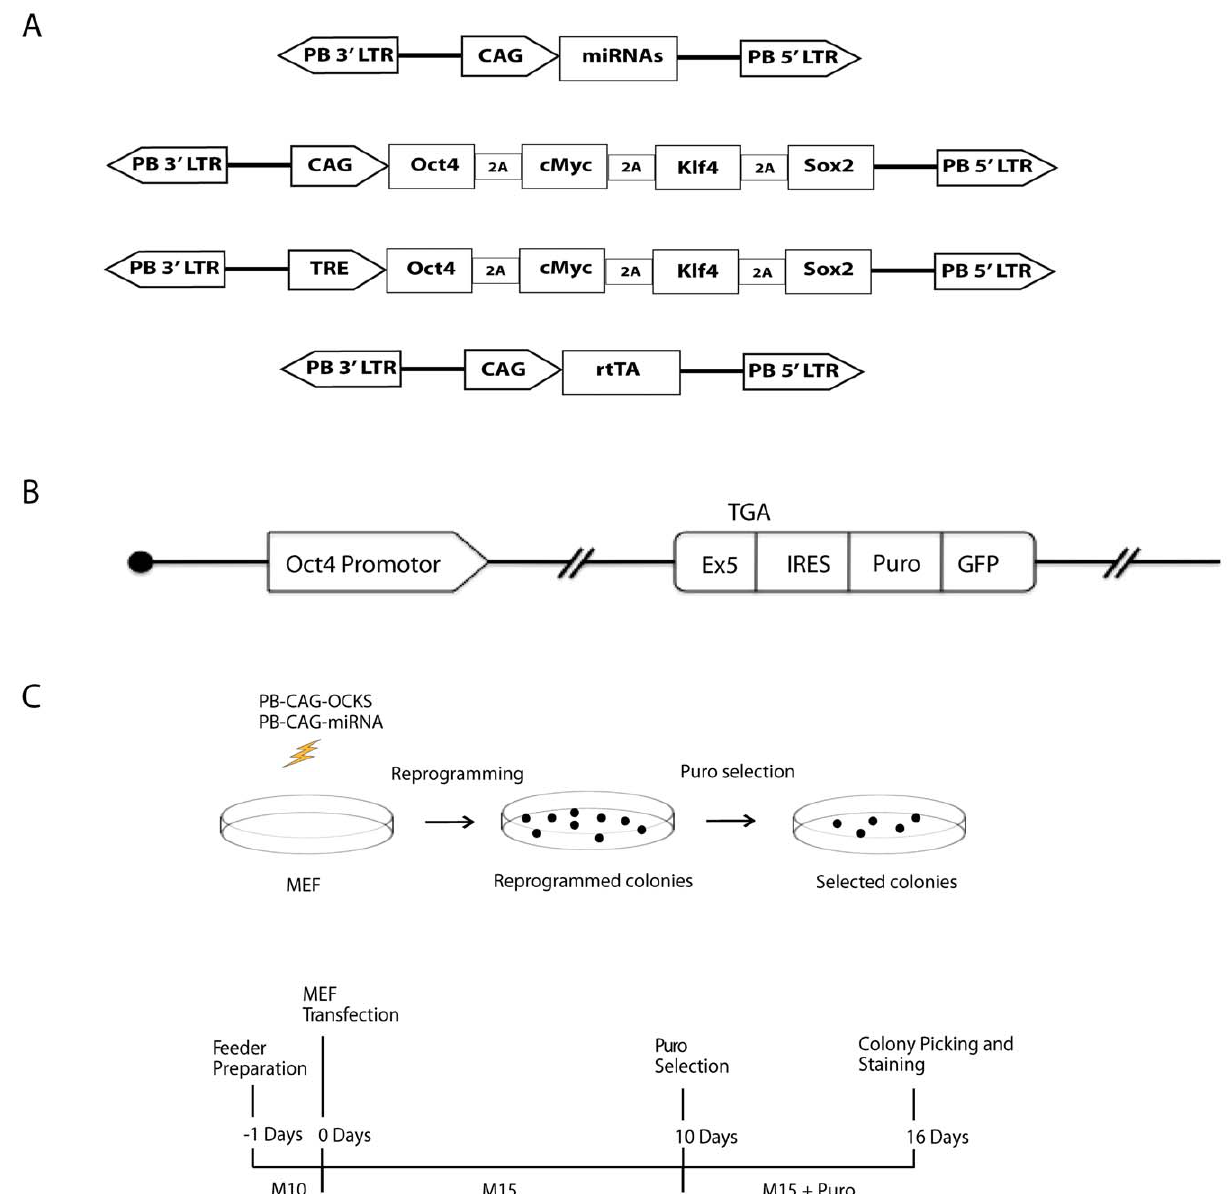
Figure 1. Reprogramming MEFs using PB transposons carrying the four Yamanaka factors and miRNAs. a. Schematic diagrams of the PB transposon constructs. Mouse cDNAs for Oct4 , c-Myc , Klf-4 and Sox2 (OCKS) were cloned under the control of either the CAG promoter or the TRE (Tet responsive element). Expression of rtTA (reverse tetracycline transactivator) and the miRNAs was controlled by the CAG promoter. cDNAs of OCKS were joined by a linker encoding the 2A peptide. b. The Oct4- reporter allele. The IRES-PuroGFP cassette was targeted to the 3 9 UTR of Oct4 locus, immediately after the TGA stop codon in exon 5. c. Timeline of the reprogramming strategy. MEF cells were transfected with the transposon constructs and plated onto STO feeder cells. Puromycine (2.0 m g/ml) was added to select for Oct4 expression on day 10. If the Dox-inducible transposon (PB-TRE-OCKS) was used, Dox (1.0 m g/ml) was added one day after transfection. doi:10.1371/journal.pone.0040938.g001 TRE-OCKS, and performed RT-PCR using RNA samples from iPSCs growing in the presence or the absence of Dox. As shown in Fig. 3e, Dox induced robust expression of the Yamanaka factors, while withdrawing Dox completely shut down their expression in the majority of examined iPSC lines (Fig. 3e).